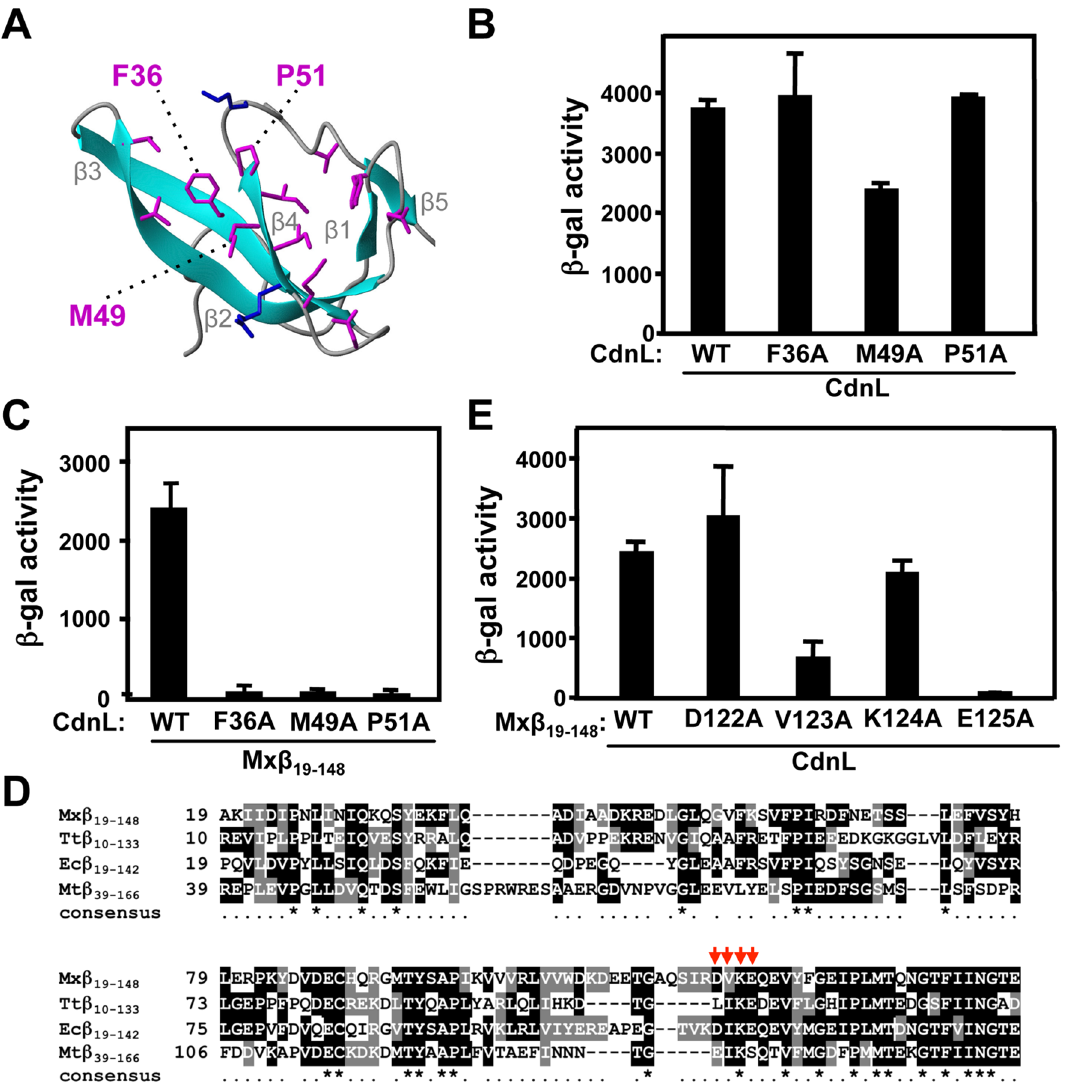
Figure 4. Mutational analysis of CdnL interaction with RNAP- b . ( A ) Native CdnLNt structure showing residue side chains that may contact RNAP- b , with the three labeled tested by mutational analysis (see text). ( B ) BACTH analysis showing that the F36A, M49A and P51A CdnL variants self- interact in cells with the pKT25 and pUT18 constructs of wild type or mutant cdnL , as indicated. ( C ) BACTH analysis of the interaction with Mx b 19–148 (in pUT18C) of CdnL F36A, M49A, or P51A mutants in pKT25. ( D ) Sequence alignment of the M. xanthus RNAP- b segment, Mx b 19–148 (NCBI code, YP_631280.1) and its equivalents in T. thermophilus , Tt b 10–133 (WP_014630291), in E. coli, Ec b 19–142 (P0A8V2), and in M. tuberculosis (CAB09390). Residues shaded black if identical, or grey if similar, in at least two of the aligned sequences. An asterisk in the consensus line below indicates conservation in all four sequences. Red arrows point to RNAP- b residues analyzed by site-directed mutagenesis in this study. ( E ) BACTH analysis of the interaction of Mx b 19–148 (WT) or its indicated mutants in pUT18C versus wild-type CdnL in pKT25. RNAP interactions (Figure 5B). Mutations of corresponding basic residues in MtCdnL have been reported to reduce its DNA binding in vitro , with that equivalent to R90A/R91A/R93A producing the greatest effect [21], but their consequences in vivo have not been described. It is thus noteworthy that mutating the basic R90/R91/R93, but not R128/K129, is detrimental to function in vivo despite no apparent DNA binding by M. xanthus CdnL. Additionally, the lack of an effect on mutating the highly conserved W88 in M. xanthus CdnL contrasts with the observation that the equivalent mutation in MtCdnL or TtCdnL impairs function [18,21]. Altogether, these data reveal that a stretch of basic residues in the CdnL C-terminal domain is crucial for its essential function in M. xanthus .